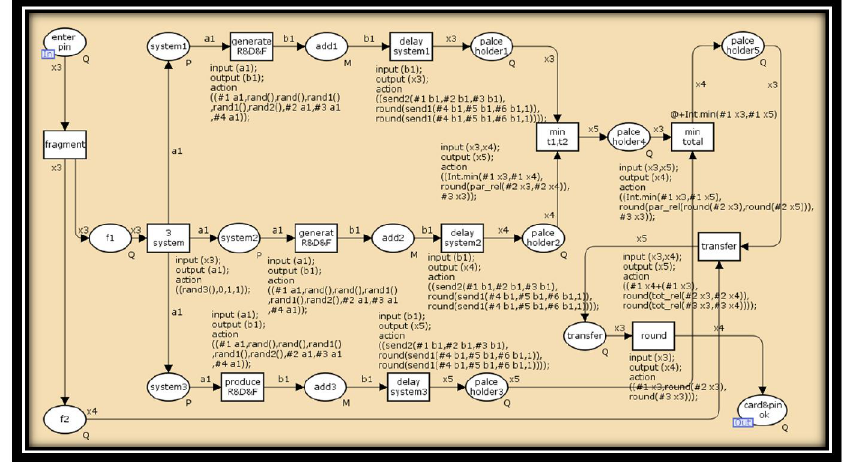
Fig. 9. Subpage for wait pin